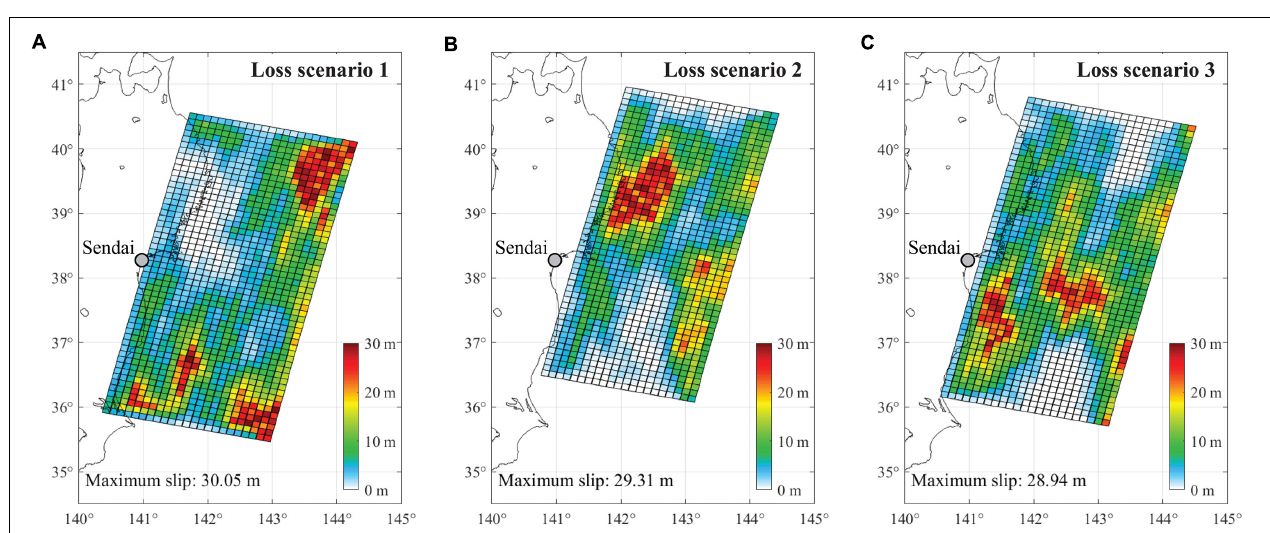
FIGURE 5 | Earthquake slip models of M w 9.0 events corresponding to three loss scenarios identified for Sendai: (A) loss scenario 1 (10th percentile of total loss), (B) loss scenario 2 (50th percentile of total loss), and (C) loss scenario 3 (90th percentile of total loss).